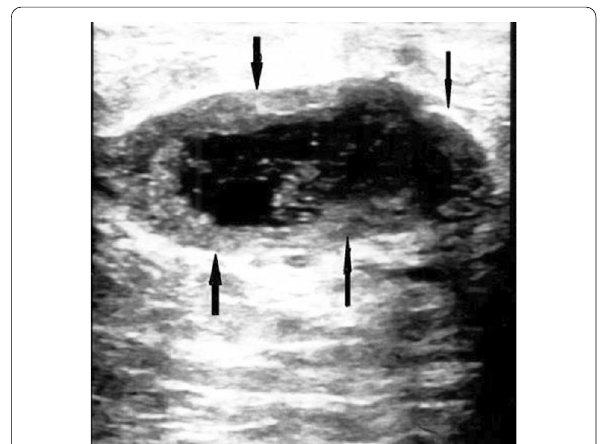
Fig. 6 Abscess with irregular thick walled cystic lesion with echoes in it, on aspiration frank pus was aspirated in a young patient of 26 years of age with history of recent termination of breast